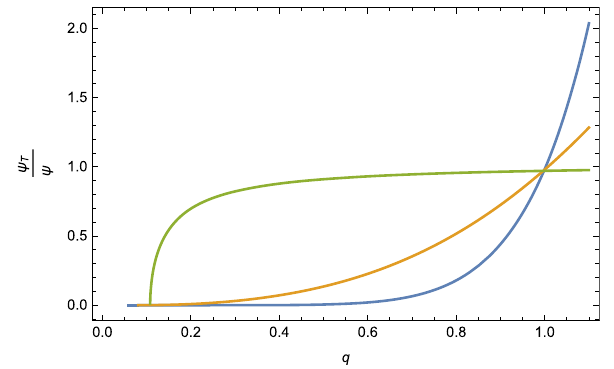
Fig. 7 Case 3. ψ T (ψ as a function of q for j c = 0 . 3, and various p ( a r ) T ) (cid:19) values. 0 . 3729 ( 0 . 1 ) (blue line), 0 . 3887 ( 0 . 5 ) (orange line), 0 . 2897 ( 1 . 0 ) (green line). Figure 6 provides the p values